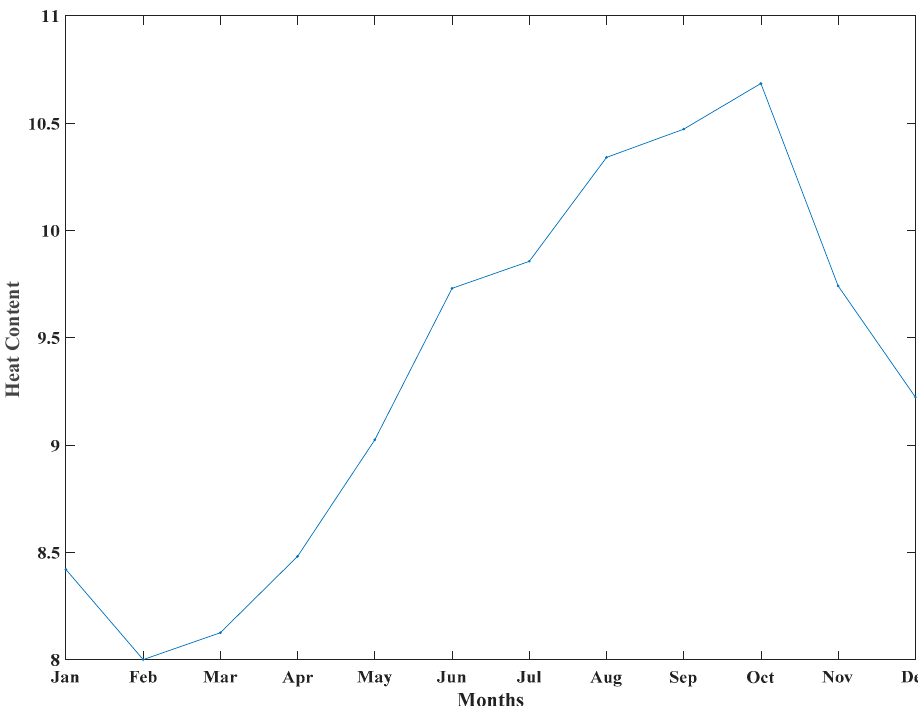
Figure 6. Monthly average heat content (×10 7 Jm − 2 ) for the entire gulf up to 35 m depth.